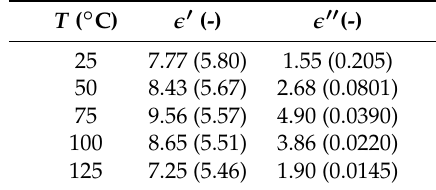
Table 1. Selected values of dielectric constant and loss factor for the industrial frequency of 50 Hz.